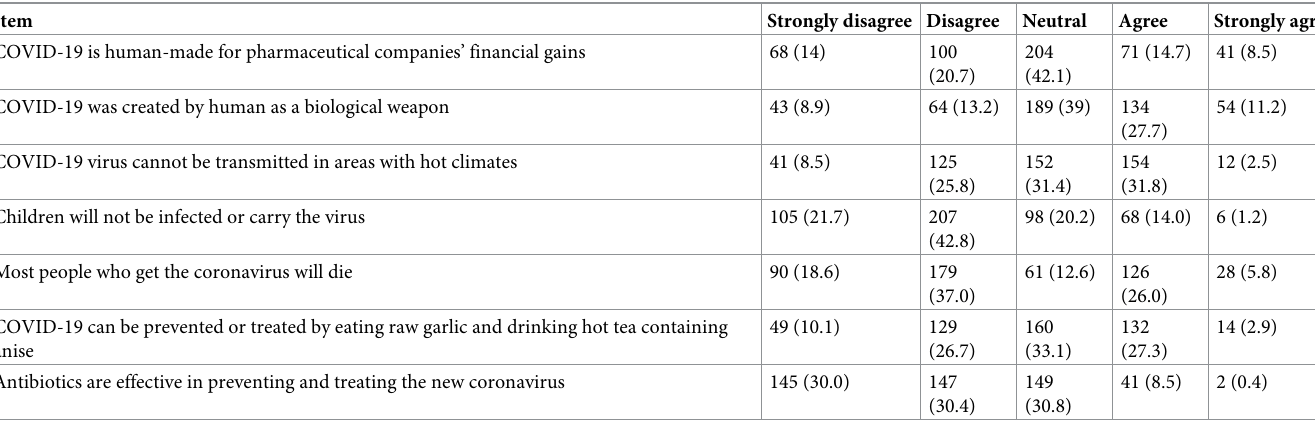
Table 2. Covid-19 misinformation (n =